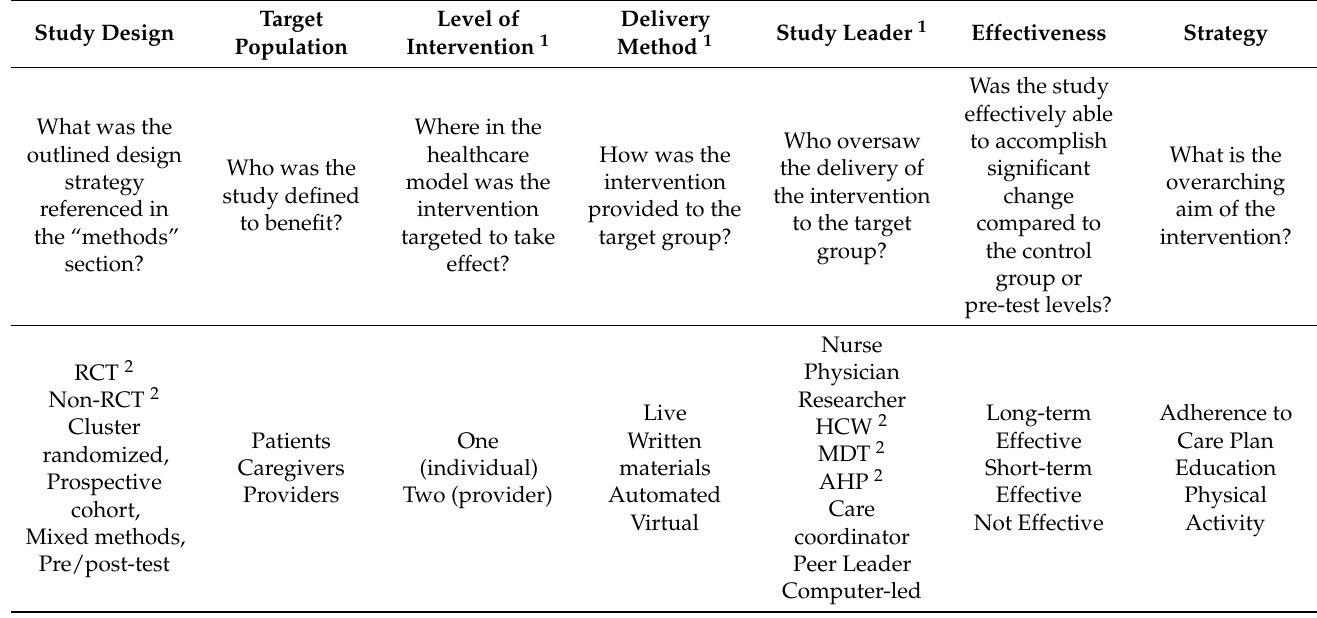
Table 1. Summary of Study Definitions and